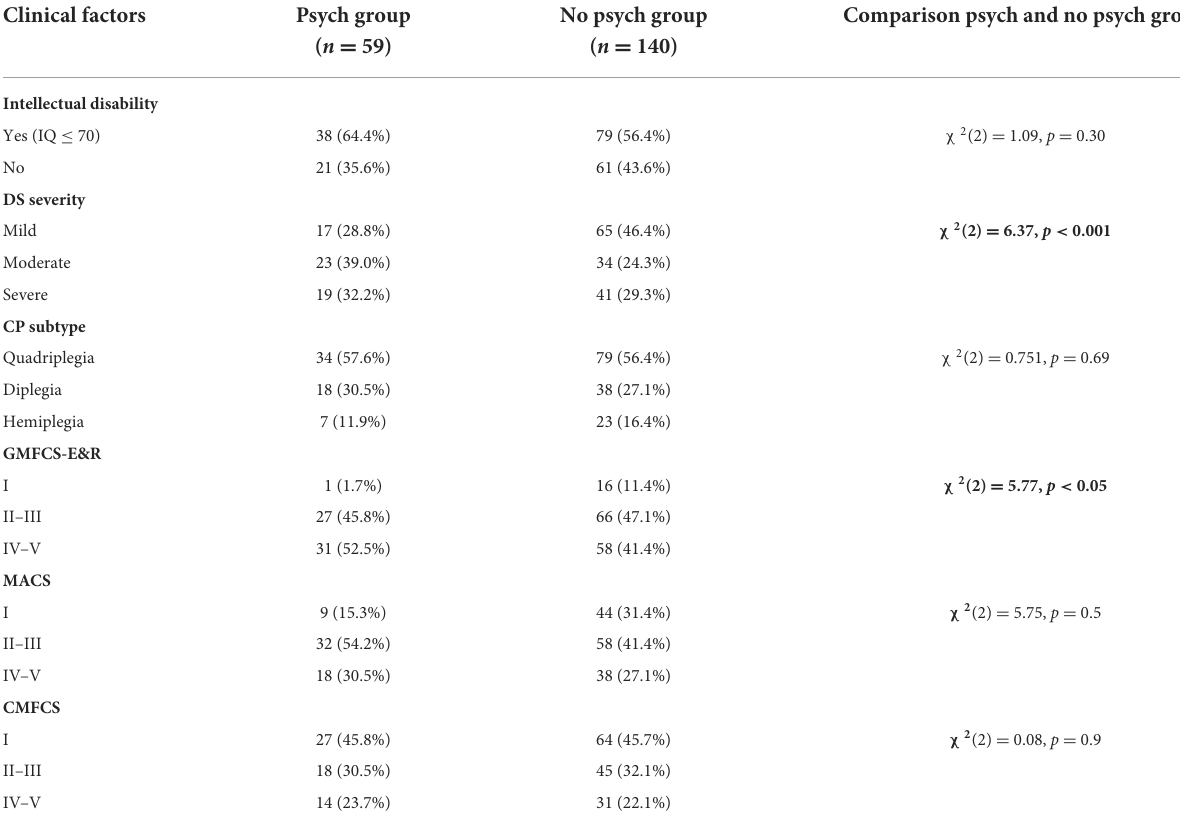
TABLE 3 Clinical characteristics of the whole group of patients. The chi-square was used for comparisons between groups. Clinical factors Psych group No psych group Comparison psych and no psych ( n = 59) ( n = 140)